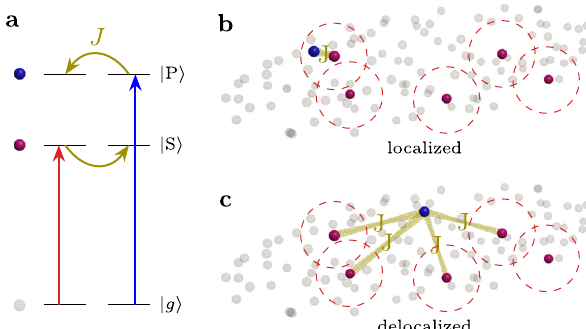
Fig. 1 Sketch of the experiment. a Dipole – dipole interaction between two atoms. One ground state atom g j i (gray) is excited to a Rydberg S j i -state (red) with a two-photon transition (red arrow). A second atom is excited to a Rydberg P j i -state (blue) with a single-photon transition (blue arrow). Hopping with strength J (yellow arrows) is induced by resonant dipole – dipole coupling between the two Rydberg states of opposite parity. b , c Spatial distribution of Rydberg excitations corresponding to localized and delocalized states. Seed atoms in the Rydberg S j i -state (red) are separated by the Rydberg blockade radius (red dashed circles). Probe excitations to the Rydberg P j i -state are shown in blue. Surrounding ground state atoms are shown in gray. Yellow connections illustrate the strongest hopping contributions. They can be restricted to two sites only, forming a localized dimer state ( b ), or to multiple similarly spaced sites, forming a delocalized state ( c